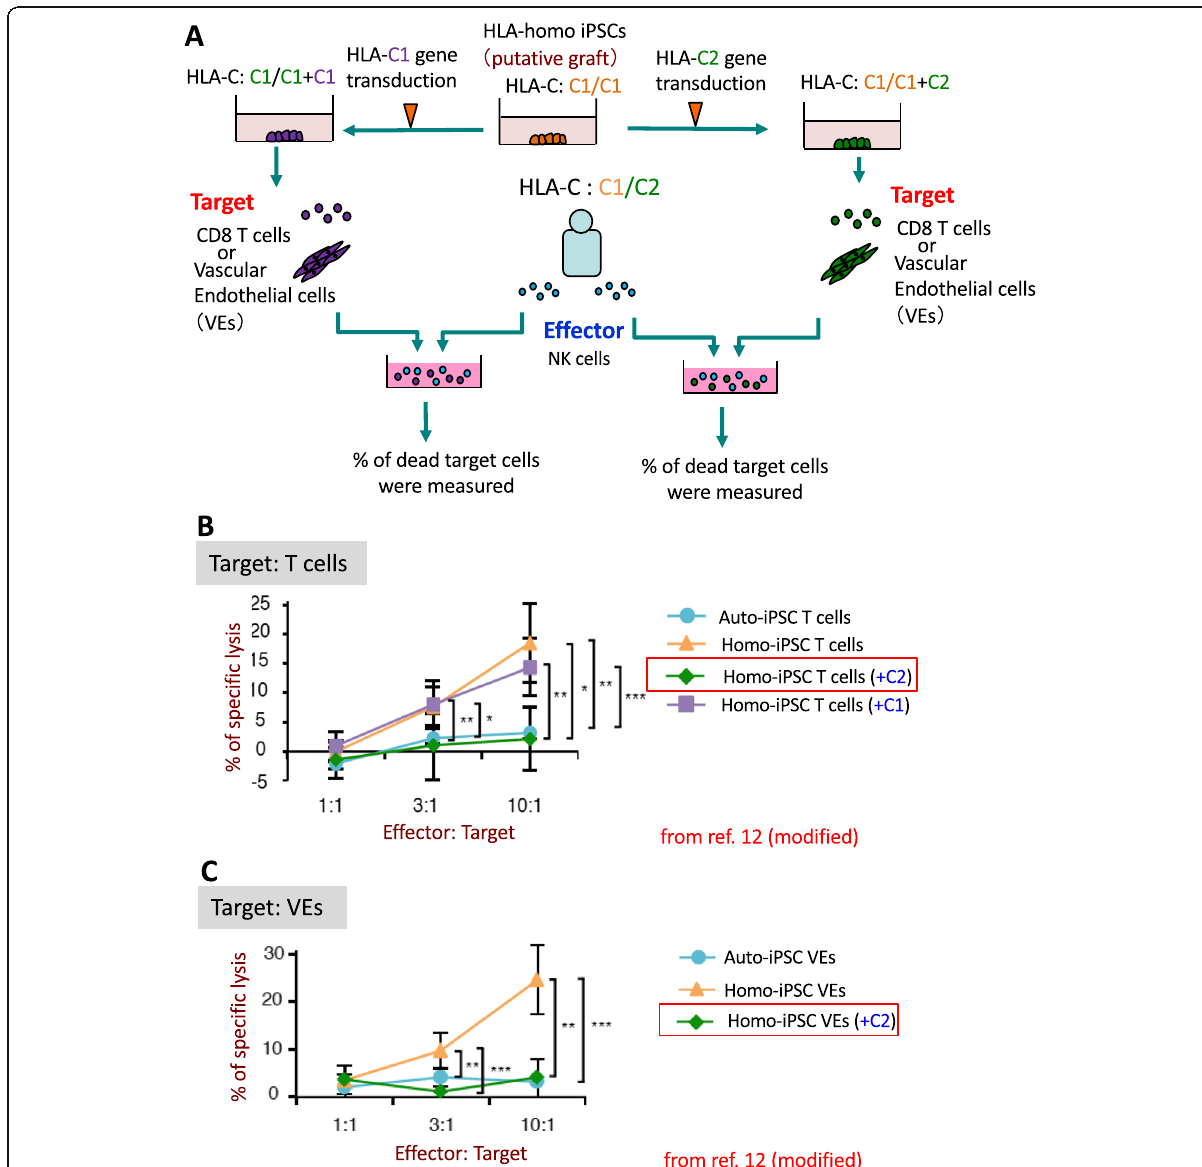
Fig. 4 Ectopic expression of the HLA-C2 molecule in regenerated grafts suppresses NK cell alloreactivity. a Schematic illustration of the experimental design. HLA-homo-C1/C1 iPSCs were transduced to express type 2 HLA-C allotype that is identical to the putative recipient using a lentiviral system. As negative control, HLA-homo-C1/C1 iPSCs transduced with HLA-C1 gene were also produced. Regenerated T cells or VEs from these iPSCs were used as target cells. After effector and target cells were co-cultured for 6 h in different E:T ratio ’ s, the percentage of dead target cells were measured by Cr 51 -release assay. b Cytotoxic assay of NK cells isolated from the putative recipient against different iPSCs-derived T cells. * p < 0.05, ** p < 0.01, *** p < 0.001, Student ’ s t test. c Cytotoxic assay of NK cells isolated from the putative recipient against different iPSCs- derived VEs. ** p < 0.01, *** p < 0.001, Student ’ s t